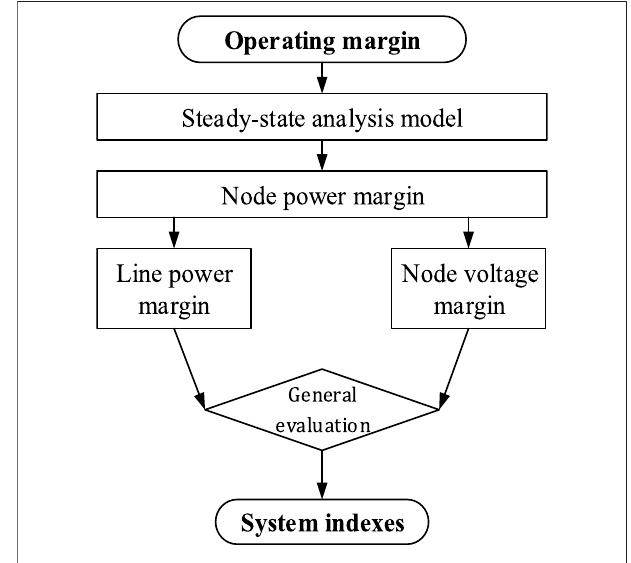
FIGURE 1 | Analytical structure of this